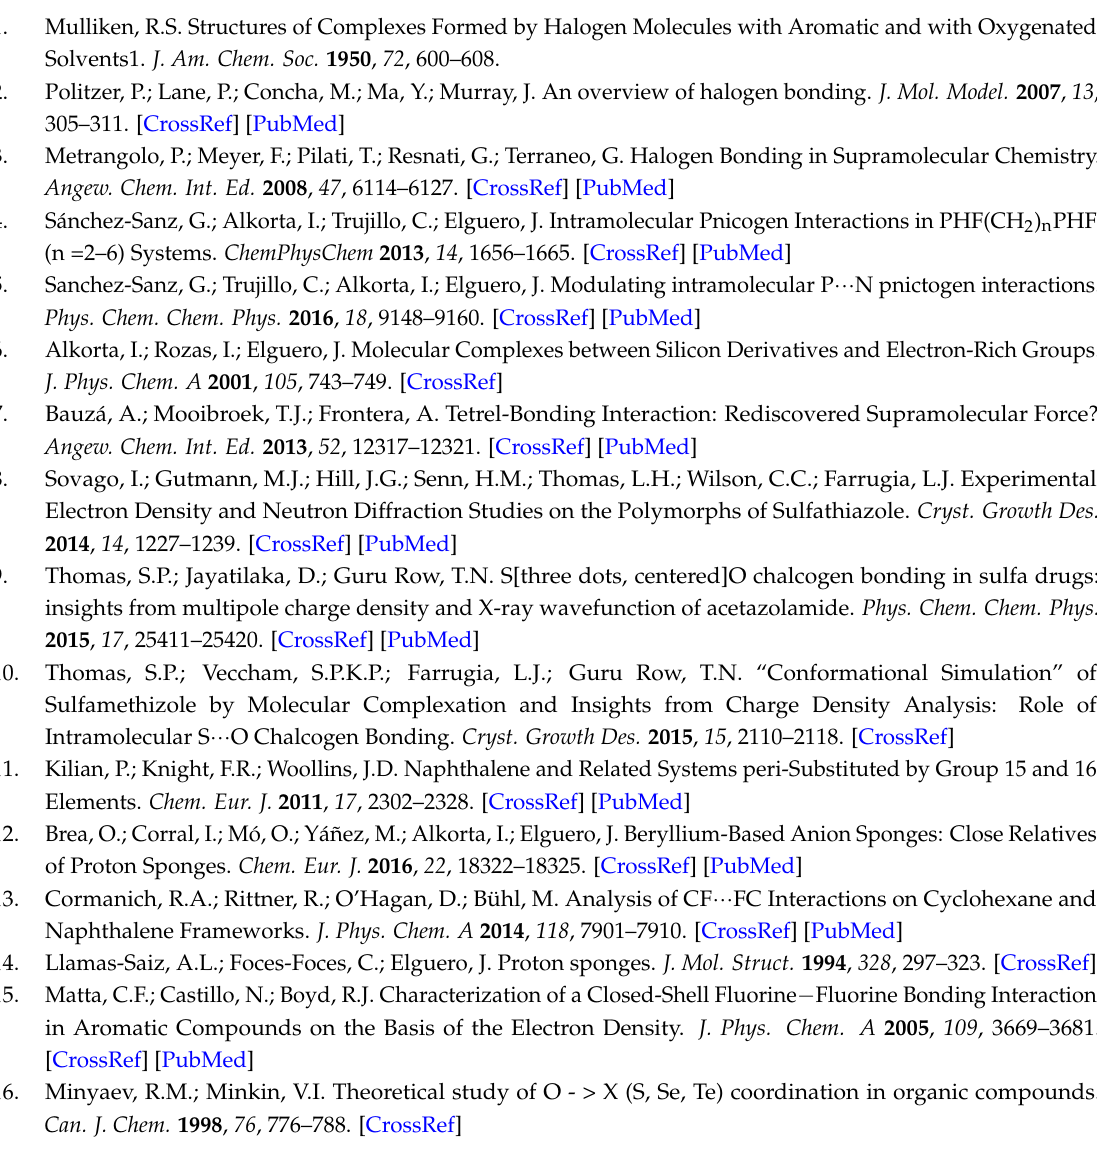
IMYB 2 compounds at MP2/aug-cc-pVTZ computational level. Table S3: Intramolecular distance, in Å, electron density, Laplacian, G, V, and total energy density, H at the bond critical point, in a.u. at the MP2/aug-cc-pVDZ computational level. Table S4: Refcode and geometrical parameters (Å and ◦ ) of CSD structures consistent with the presence of a OH ··· O HB interaction in 1,8-dihydroxynapthalene. Figure S1. Molecular electrostatic potential on the 0.001 a.u. electron density isosurface for at the MP2/aug-cc-pVDZ computational level. Figure S2. Molecular graphs corresponding to those systems with two simultaneous intramolecular interactions at the MP2/aug-cc-pVDZ computational